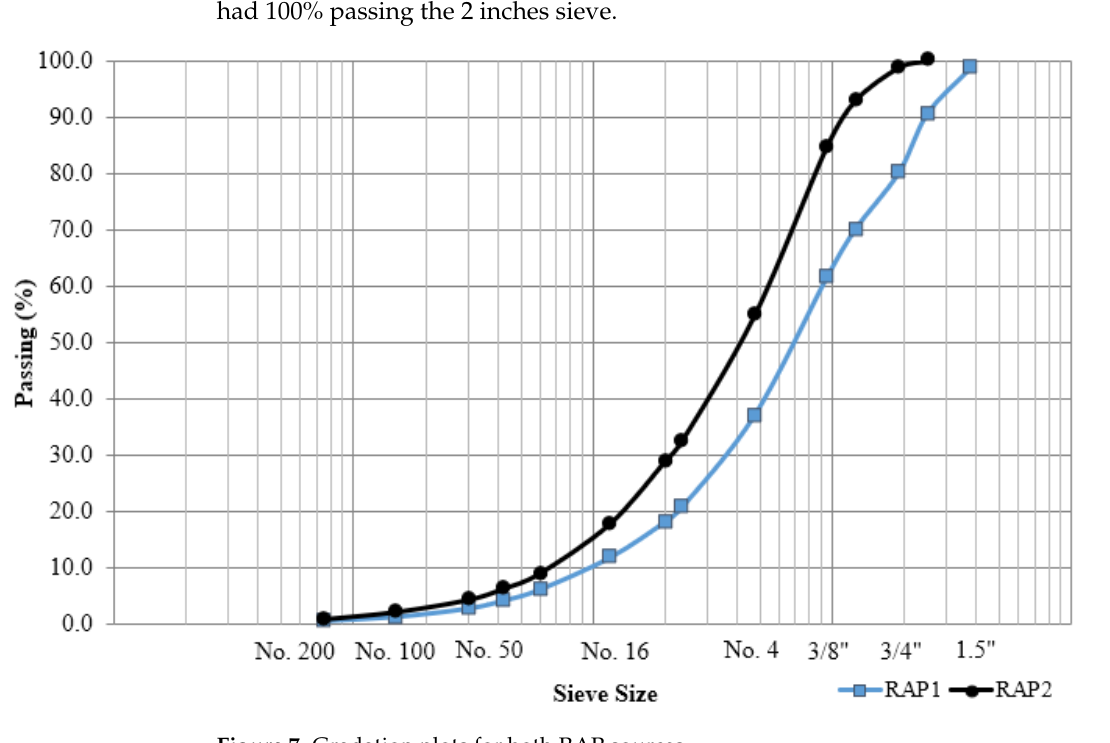
8 of 16 Table 3. Regression coefficients of Uzan model for subgrade materials. SG1